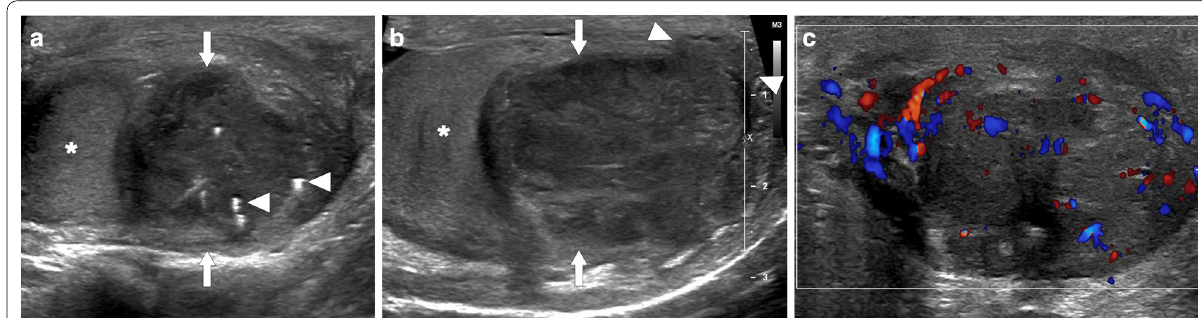
Fig. 23 Bilateral paratesticular tuberculomas. A 63-year-old male with known metastatic renal cell carcinoma being treated with chemotherapy and bladder cancer treated with intravesical BCG therapy now presenting with bilateral scrotal masses. a Gray scale US image of the right hemiscrotum shows an extratesticular hypoechoic mass (arrows) adjacent to the lower pole of the right testis (asterisk). Intralesional calcifications were also noted (arrowheads). On color Doppler US, there was a mild vascularity within this lesion. b Gray scale US image of the left hemiscrotum shows a large heterogeneous hypoechoic mass (arrows) adjacent to the lower pole of the left testis (asterisk), compressing the testicular parenchyma and extending into the testis and scrotal wall (arrowheads). c Color Doppler US of the left hemiscrotal lesion reveals widespread internal vascularity. Imaging findings were considered suspicious for malignant neoplastic processes, and bilateral inguinal orchiectomy performed. Extensive inflammation with conglomerate caseating granulomas and dystrophic calcifications were seen on the pathologic specimens. Histopathological examination confirmed paratesticular tuberculoma on the right side and paratesticular, intratesticular and scrotal tuberculomas on the left